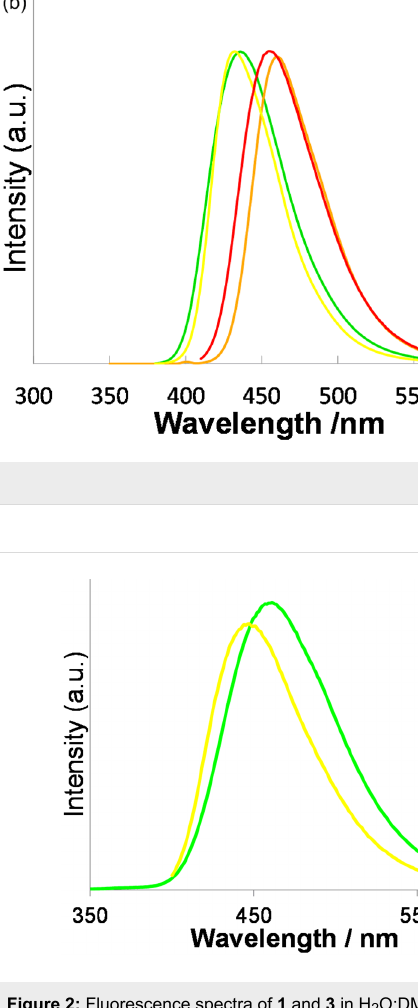
Figure 2: Fluorescence spectra of 1 and 3 in H 2 O:DMSO (9:1).